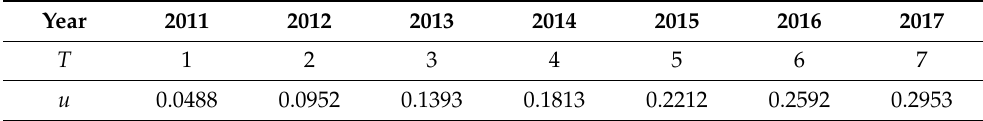
Table 3. Calculated value of u in 2011–2017.